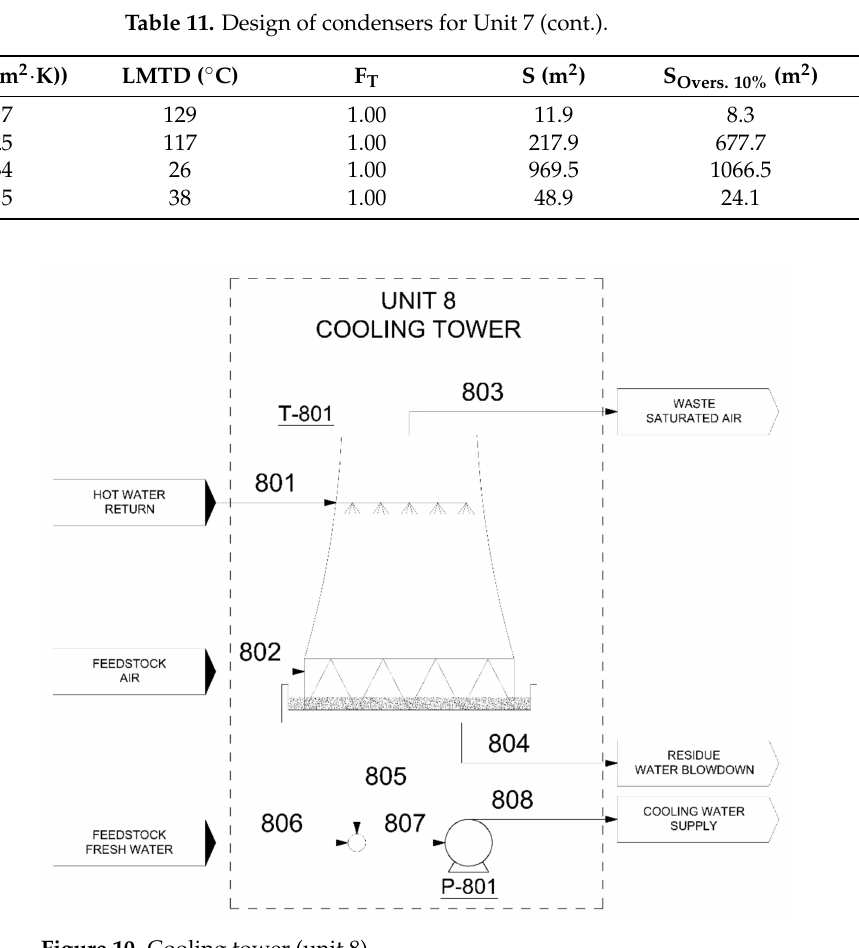
Figure 10. Cooling tower (unit